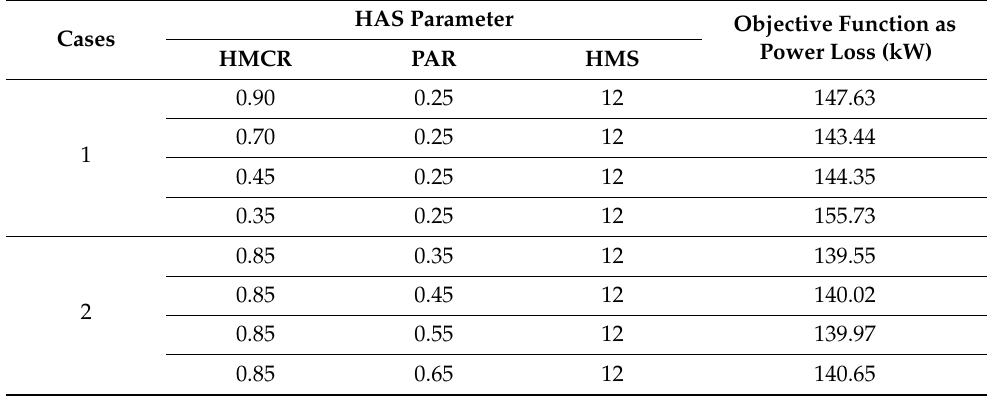
Table 4. Results based on various HSA parameters for a 33-node radial distribution